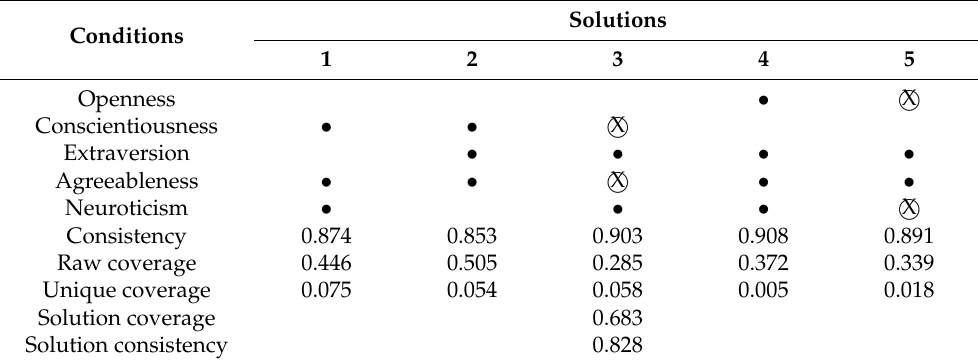
Table 6. Analysis of sufficient conditions (personality traits).